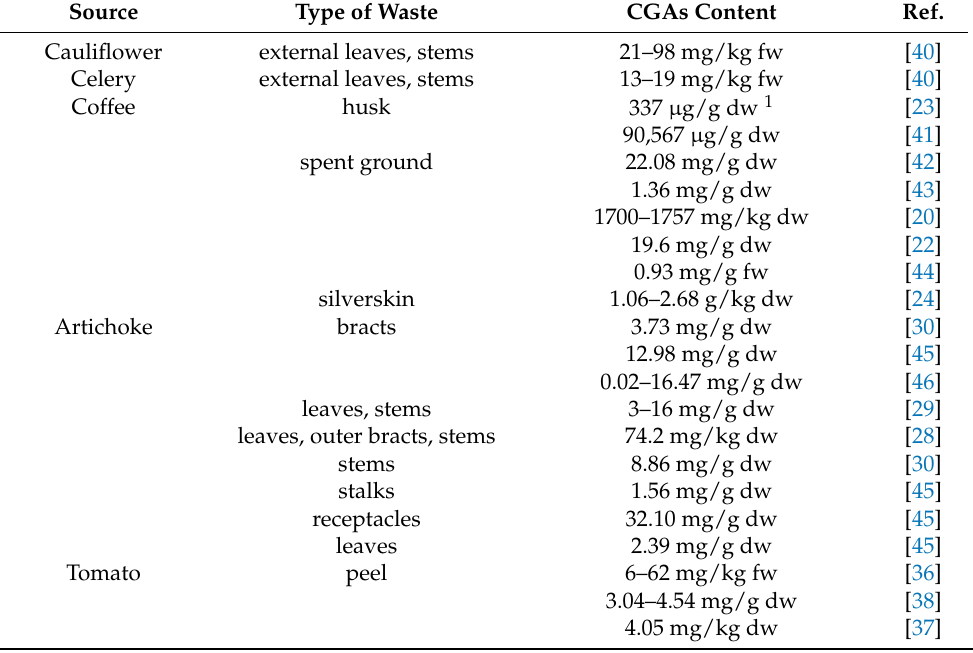
Table 1. Agri-food waste sources of chlorogenic acids (CGAs) and their relative content (referred to as fresh—fw or dry